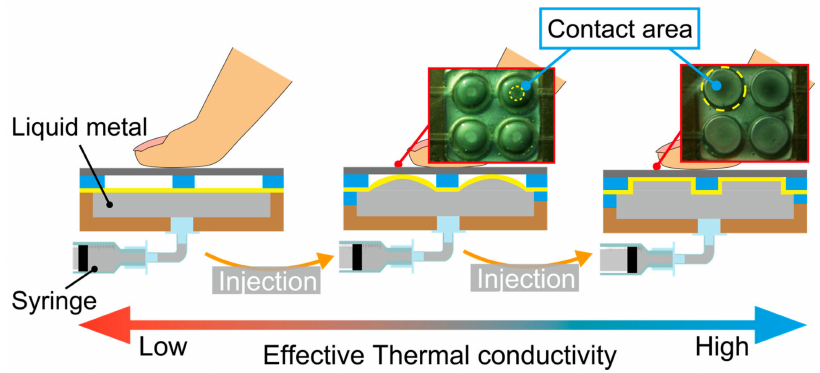
Figure 2. Conceptual sketch of the proposed thermal tactile